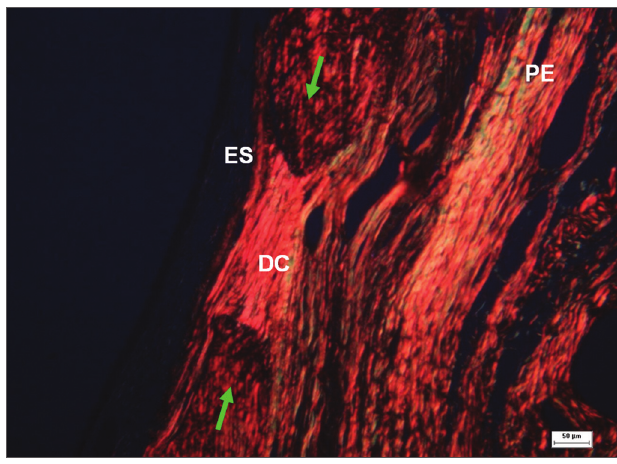
Figure 10. Histological section of an experimental surgical defect not completely filled in by bone (picro sirius red stained), under polarized light microscopy - surgical defect (DC) showing dense and parallel collagen bundles with red, orange, and yellow birefringent fibers, suggesting the presence of type I collagen; sinus epithelium (ES); periosteum (PE); bone ridges (green